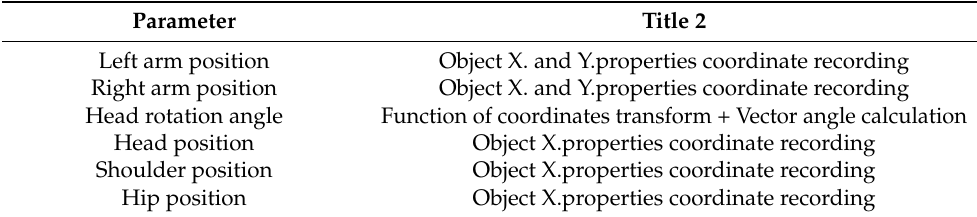
Table 4. Parameters recording methods.